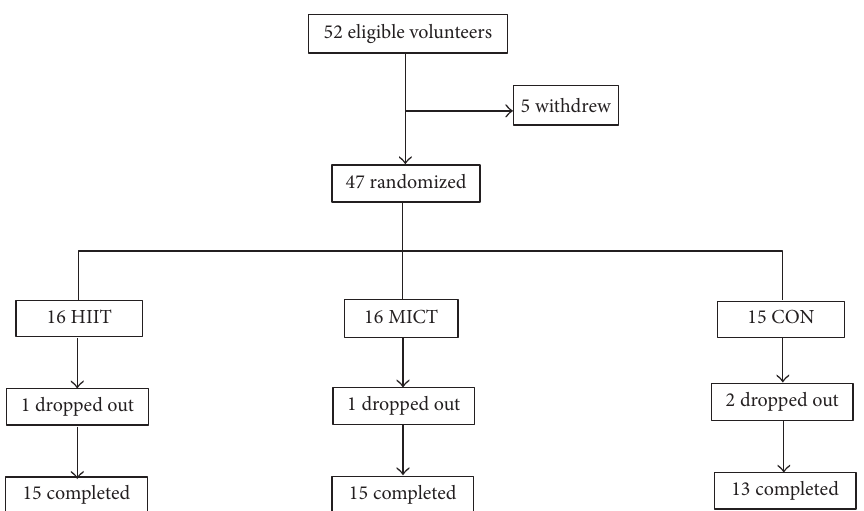
Figure 1: Distribution of study participants. HIIT, high-intensity interval training group; MICT, moderate-intensity continuous training group; CON, control